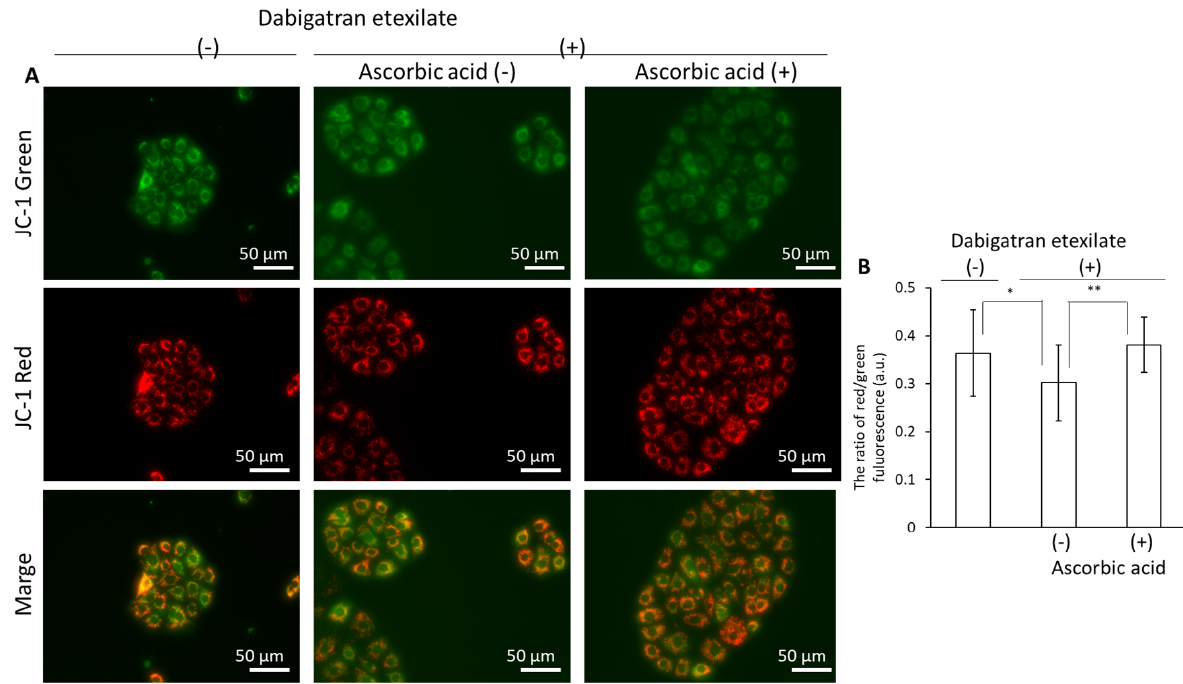
Figure 7. The fluorescence intensity of JC-1. The cells were incubated in a medium containing 25 µ M dabigatran etexilate with or without 500 µ M ascorbic acid for 6 h. After incubation, the supernatant was aspirated and the cells were incubated in a medium containing 2 µ M JC-1. The fluorescence intensity of JC-1 was measured using fluorescence microscopy. ( A ) Fluorescent microscopy utilized to assess cellular uptake of JC-1. ( B ) Data are expressed as means ± SD (n = 20). The sample size is the number of cells in the analyzed images. * p < 0.05, ** p <